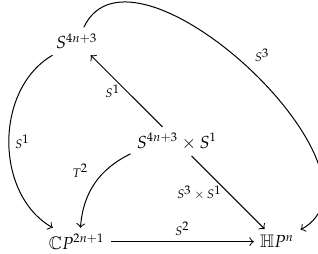
Figure 1. The prototype of foliations related to locally conformally hyperkähler